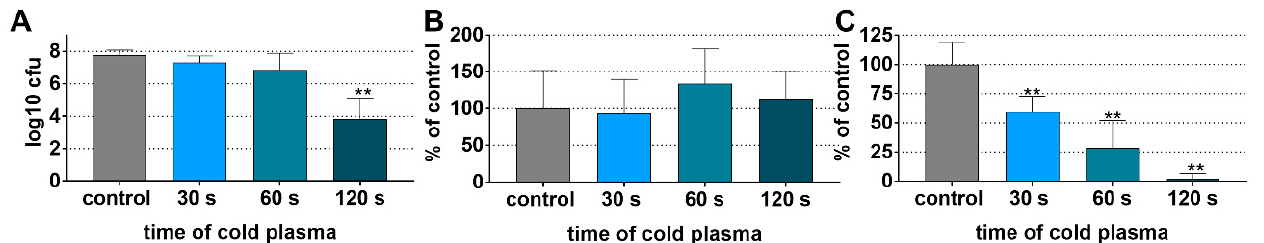
Figure 3. Colony forming units (CFU) counts ( A ), mass ( B ) and metabolic activity ( C ) of a multi- species biofilm on titanium specimens and subsequent exposing 30 s, 60 s and 120 s to cold plasma . ** p < 0.01 vs. control (post-hoc Bonferroni).